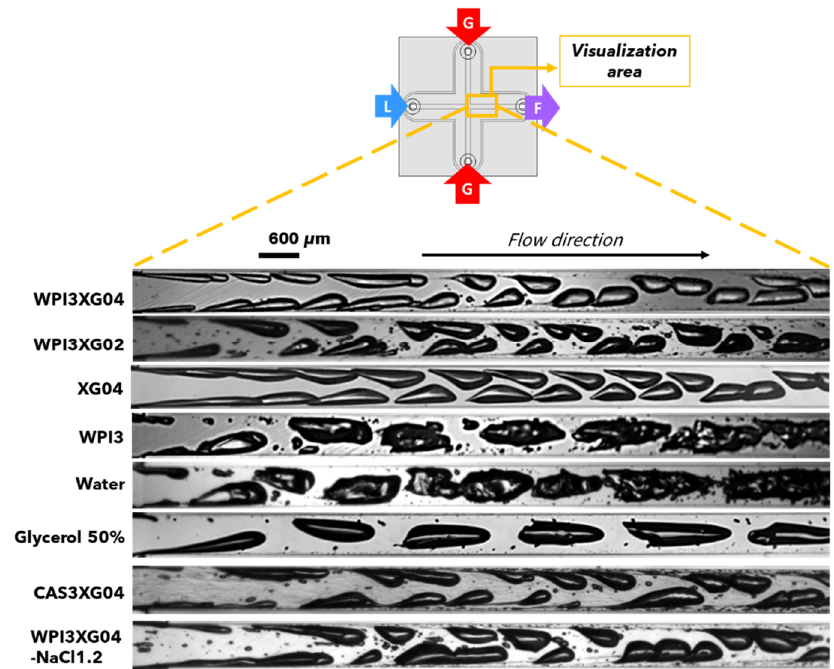
Figure 15. High-speed visualizations of the train of bubbles in the mixing channel of the device CX600 for several formulations at Q vL = 11 L · h − 1 − Q mG = 21.6 g · h − 1 . The liquid flowrate for CAS3XG04 was slightly lower (Q vL = 10.6 L · h − 1 − Q mG = 21.6 g · h − 1